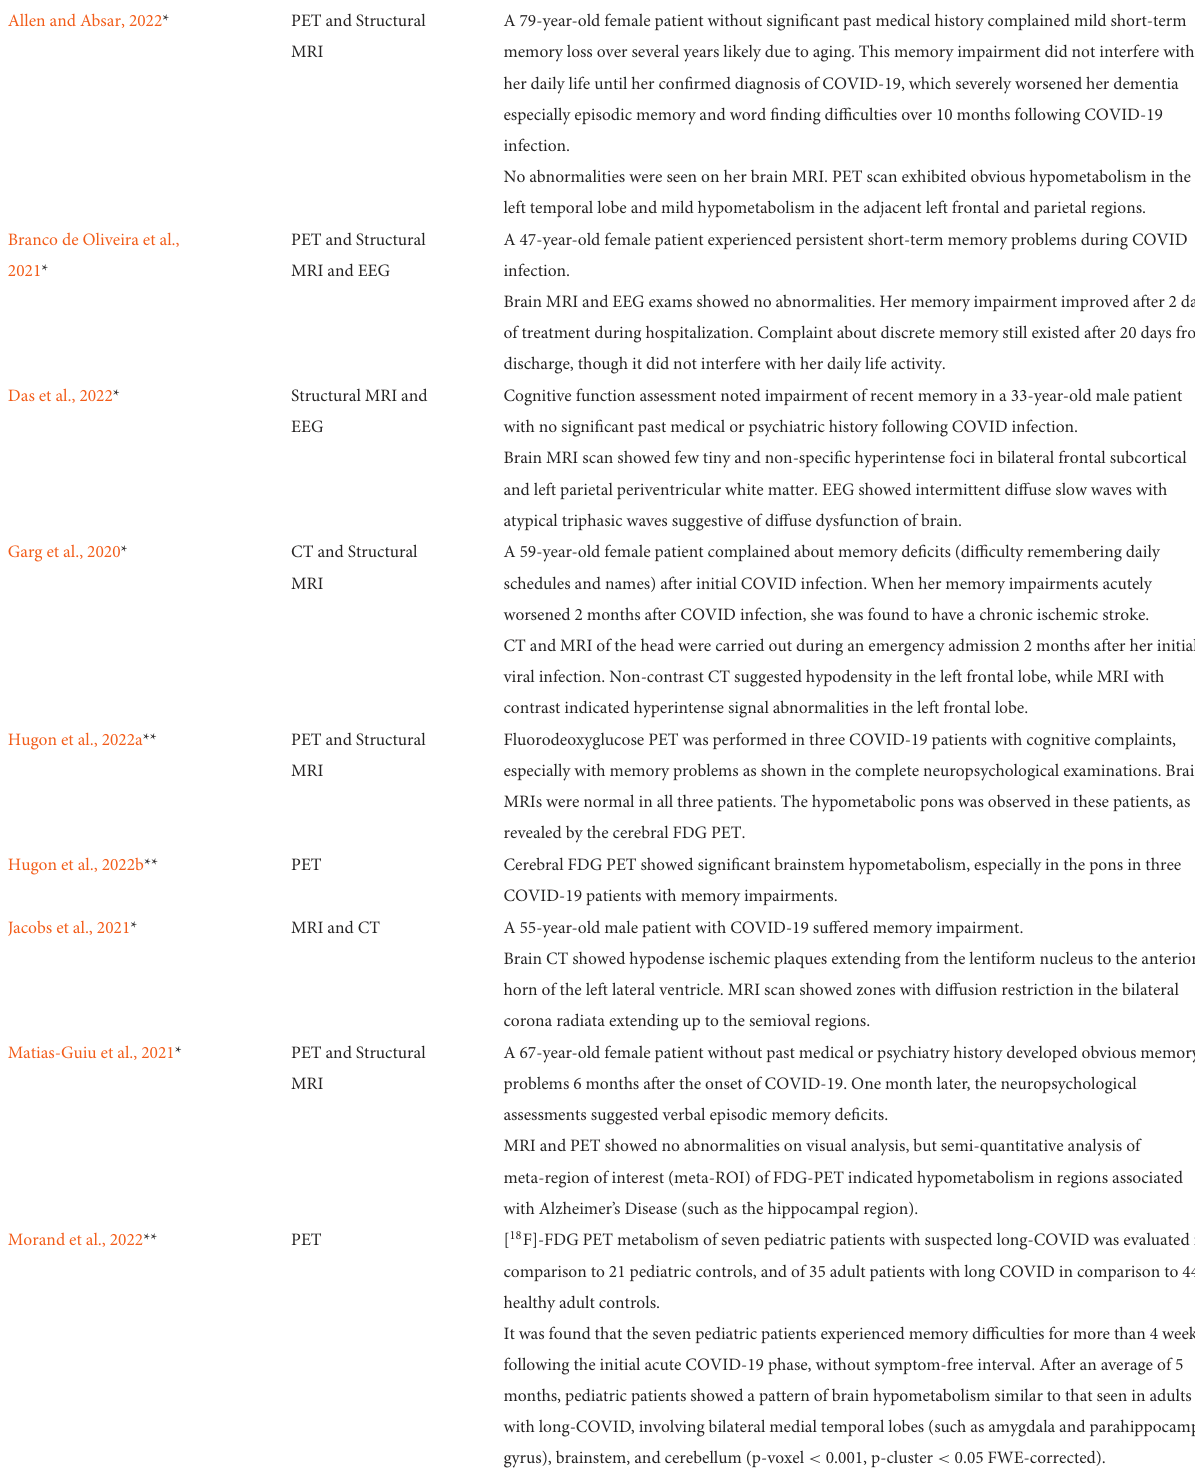
TABLE 3 Summary of study procedures and findings of included case studies and case